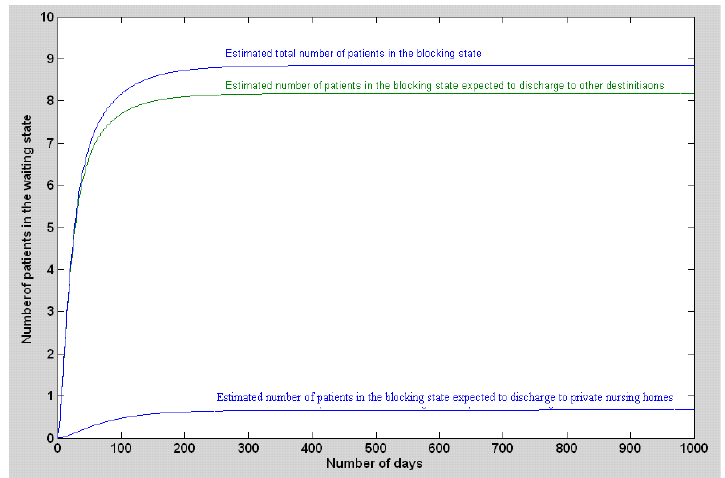
Figure 6. The estimated number of patients in the blocking state with each expected discharge destination for a mean discharge delay τ = 10 days.